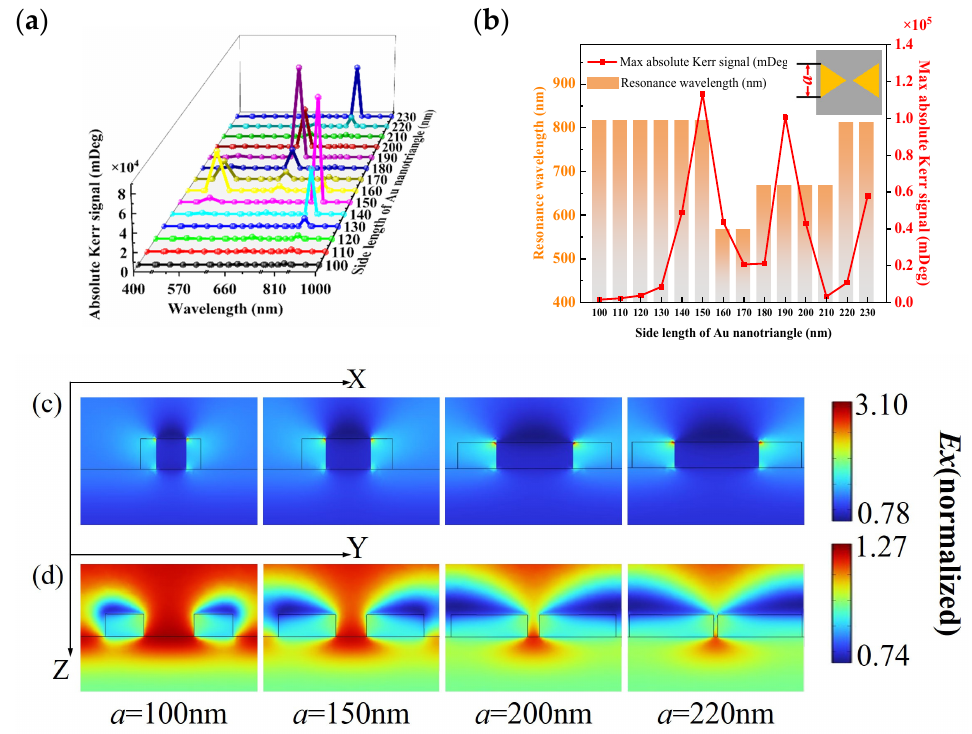
Figure 4. Wavelength dependence of PMOKE response for the Au bowties of different side length. ( a ) shows the absolute Kerr signal with difference in side length from 100 nm to 230 nm, ( b ) the maximum absolute Kerr signal and resonant wavelength, ( c ) the normalized amplitude of the X component ( Ex ) of the electric field in the XZ plane, and ( d ) the normalized amplitude of the X component ( Ex ) of the electric field in the YZ plane.